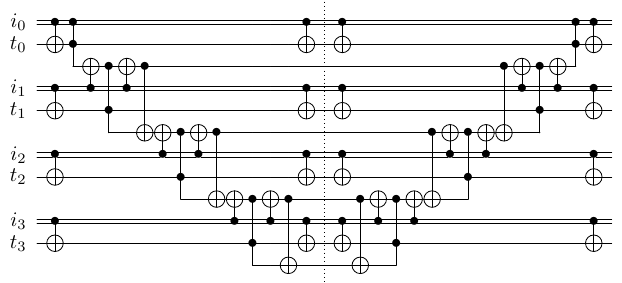
FIG. 6. A circuit to perform an inequality test with a constant giving the result in the bottom register at the dotted line. At the position of the dotted line the input registers are returned to their original values. For application of this circuit, operations that use the result of the inequality test would be put in the position of the dotted line. For the state preparation over k , the part of the circuit to the left of the dotted line would be used for prepa- ration, then the SEL operations would be performed, then the part of the circuit on the right would be used to invert the state